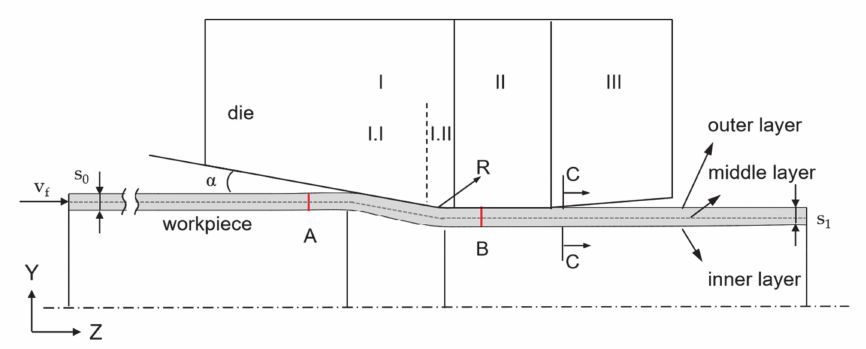
Figure 3. Featured areas and layers in the FE